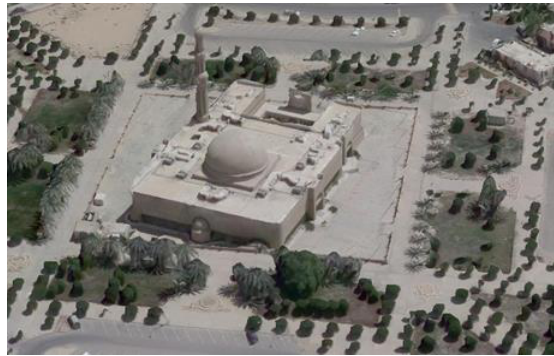
Figure 3.RGB texture from 10cm Aerial Imagery.